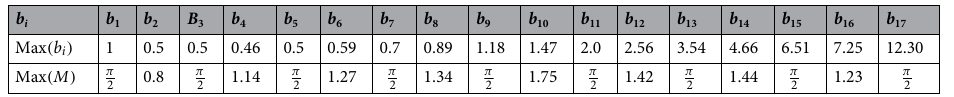
on the plane (cid:31) (cid:31)